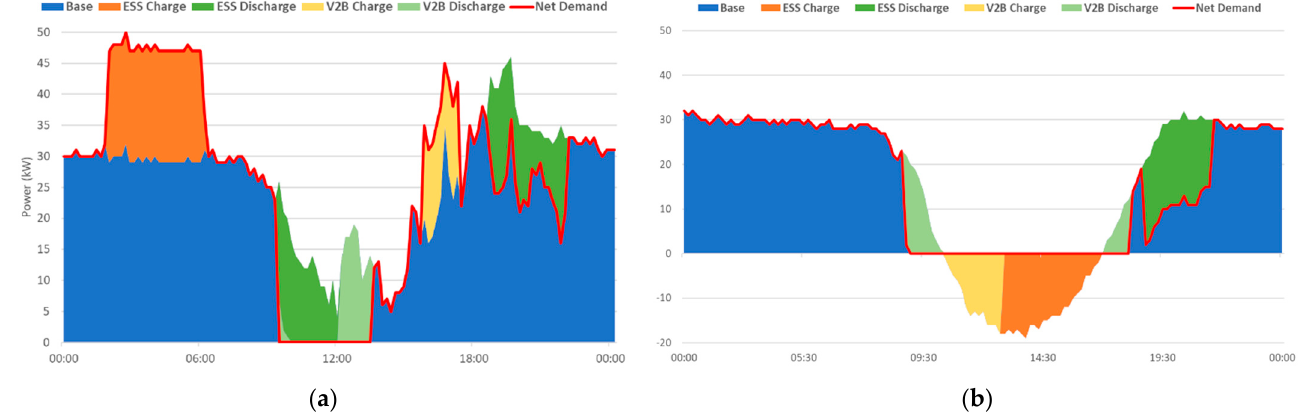
Figure 11. Scenario C: weekday ( a ); weekend ( b ).